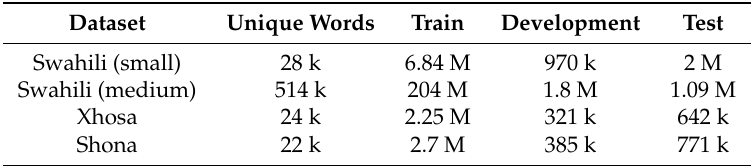
Table 3. The various datasets used in this study. The partition sizes are presented as k and M for thousand and million words,